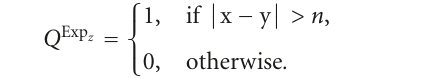
Figure 2: Advantage of the adversary for di ff erent n and N